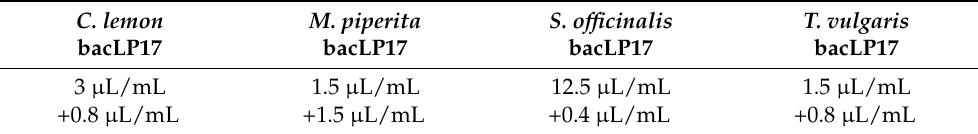
Table 3. MICs of the most advantageous EO/bacLP17 combinations (chosen based on the FIC-Index) added to the